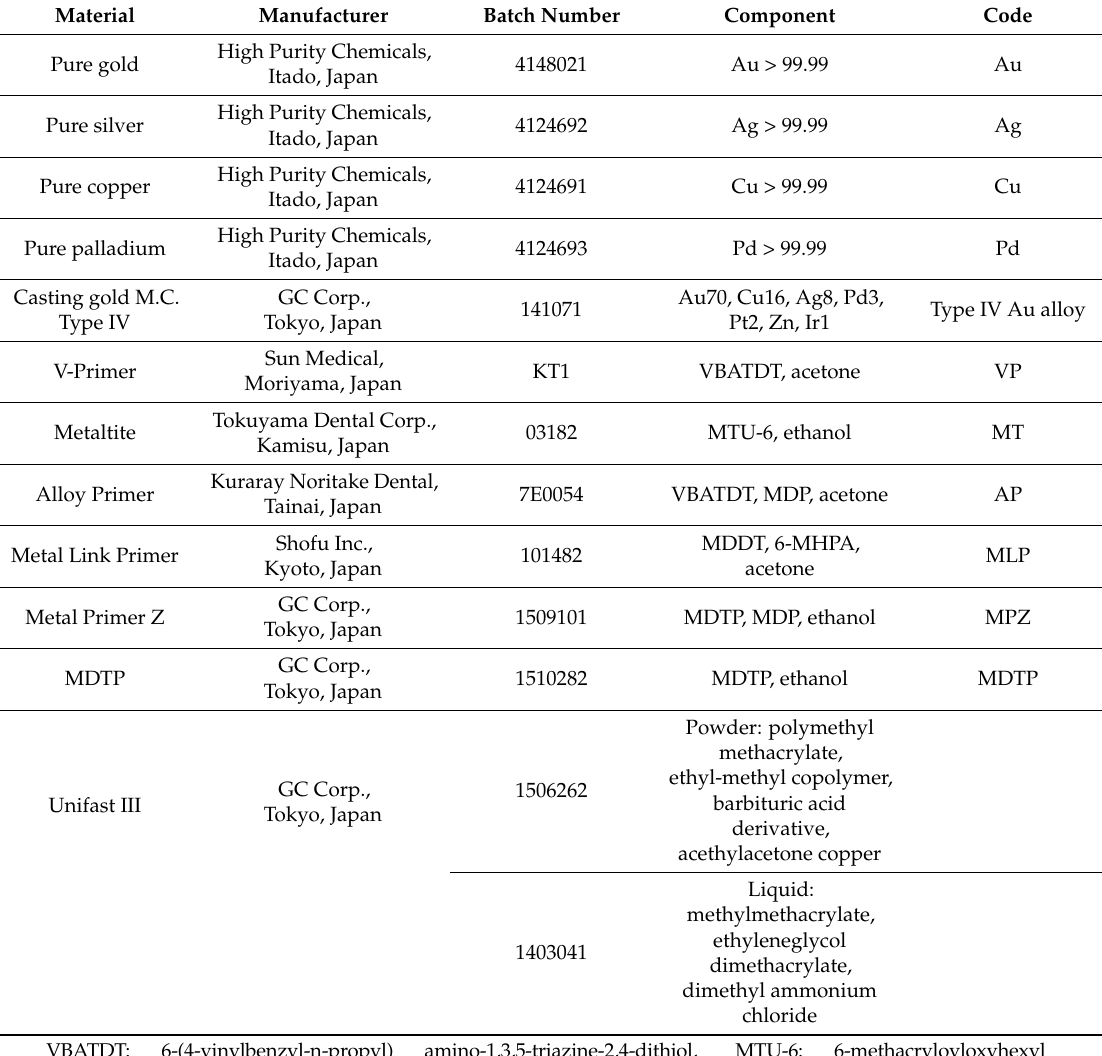
Table 1. Materials used in the